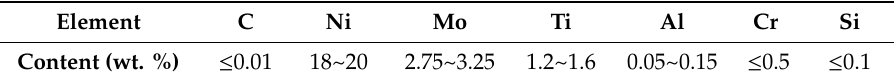
Table 1. Chemical composition of 18Ni maraging steel.